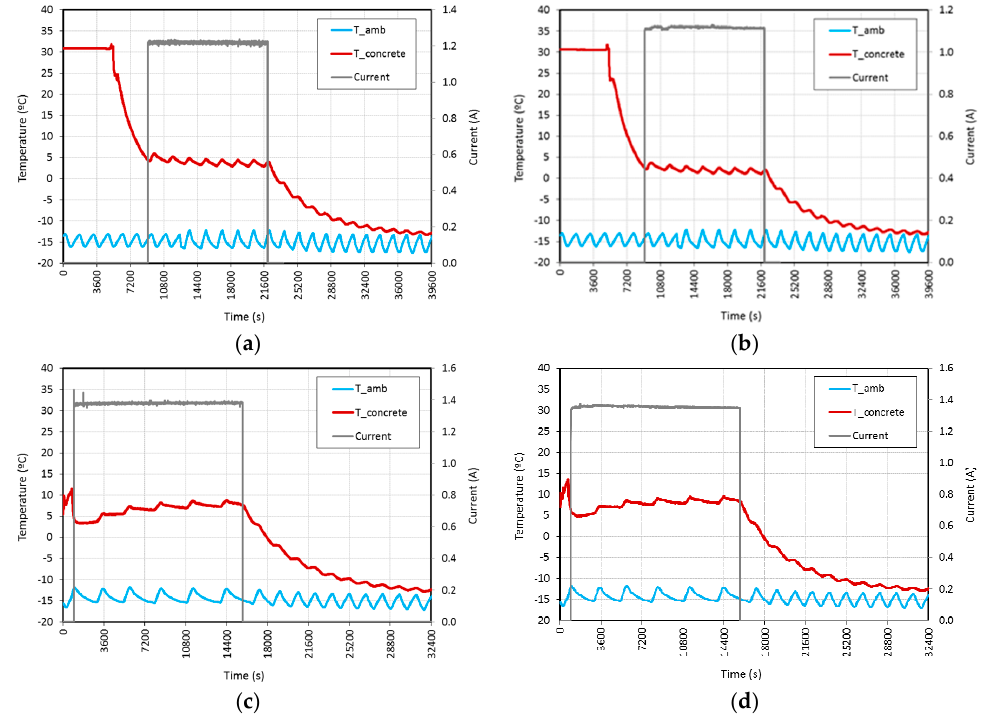
Figure 7. Prevention tests performed at fixed voltages of: ( a ) 20 V AC; ( b ) 20 V DC; ( c ) 25 V AC; ( d ) 25 V DC.